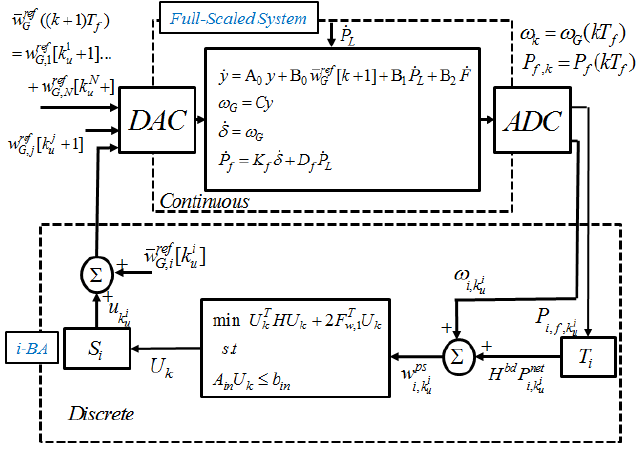
Figure 2. Distributed MPC-based